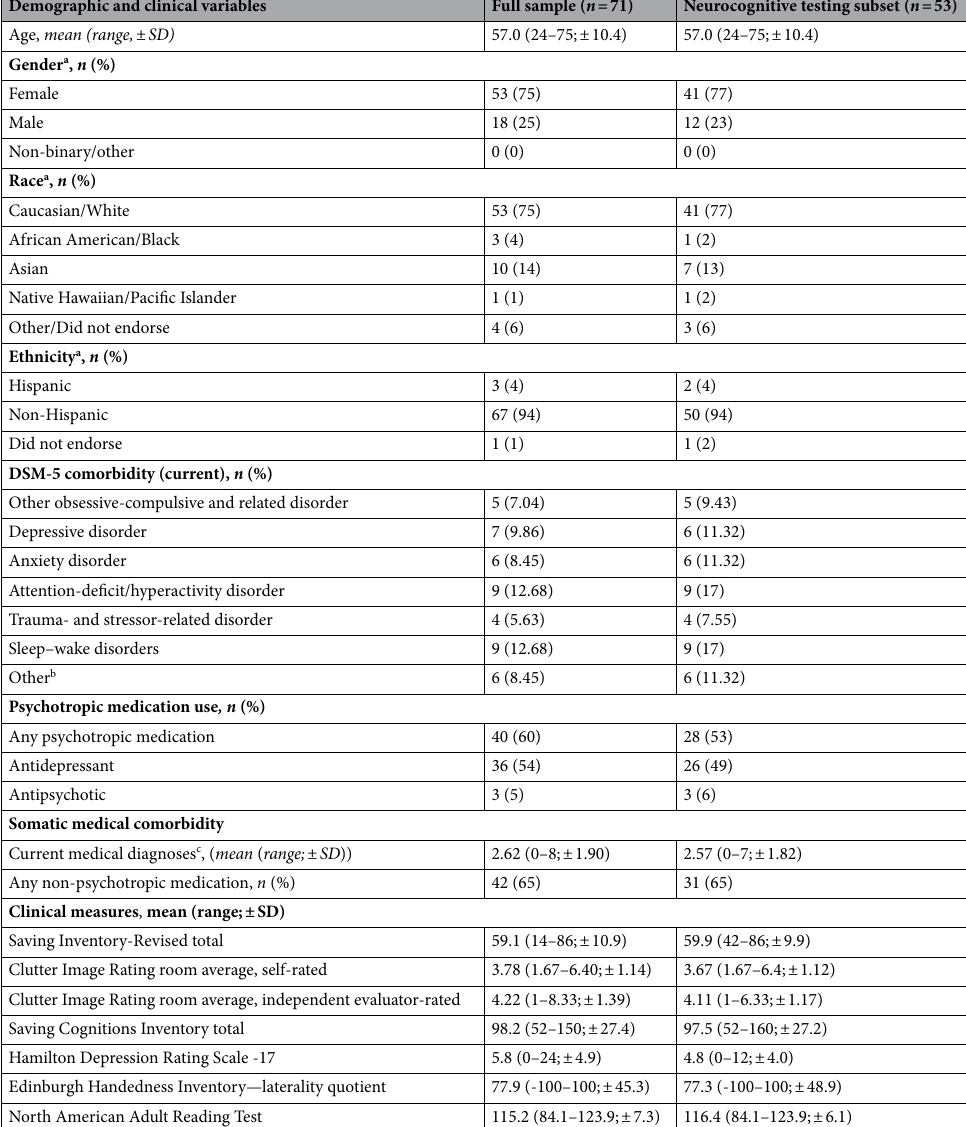
Table 1. Hoarding Disorder Participant Characteristics. a Self-asserted. b ‘Other’ includes somatic symptom disorder (n = 3), substance use disorder (n = 2), bipolar and related disorders (n = 1). c Self-reported diagnoses include the following categories/conditions (% of full sample): endocrine/metabolic (42%); cardiovascular (29%); musculoskeletal (23%), respiratory/allergic (22%), obstructive sleep apnea (17%); neurologic (16%); remitted cancer (14%); gastrointestinal (14%); urogenital (9%); rheumatologic (4%); dermatologic (3%); hematologic